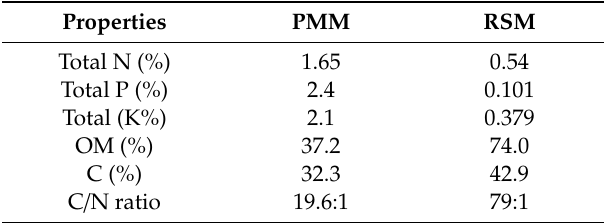
Table 3. Chemical properties of poultry manure mulch and rice straw